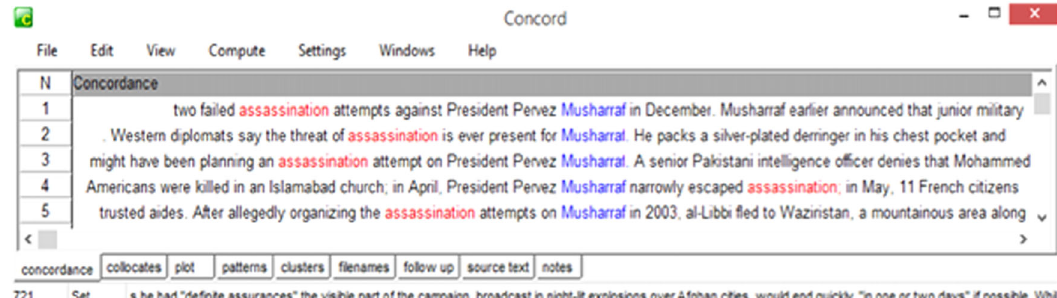
Fig. 9 Concordance extract. Concordance extract Assassination-Musharraf* .